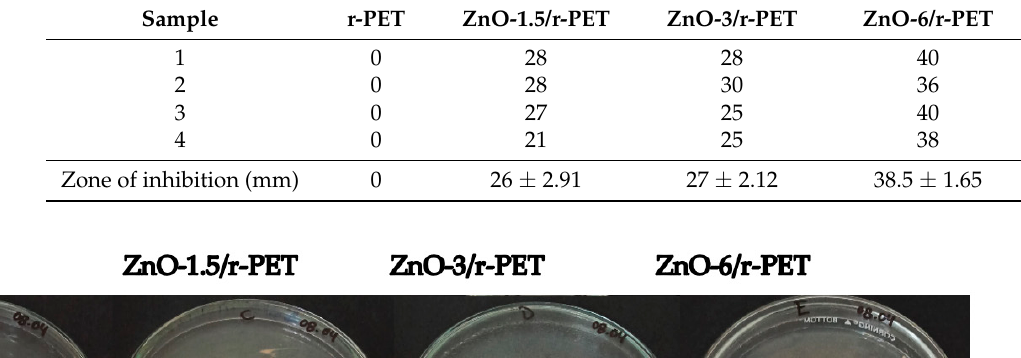
Table 4. Average diameters in millimeters of the inhibition haloes of Escherichia coli bacteria at different concentrations of ZnO-NPs.